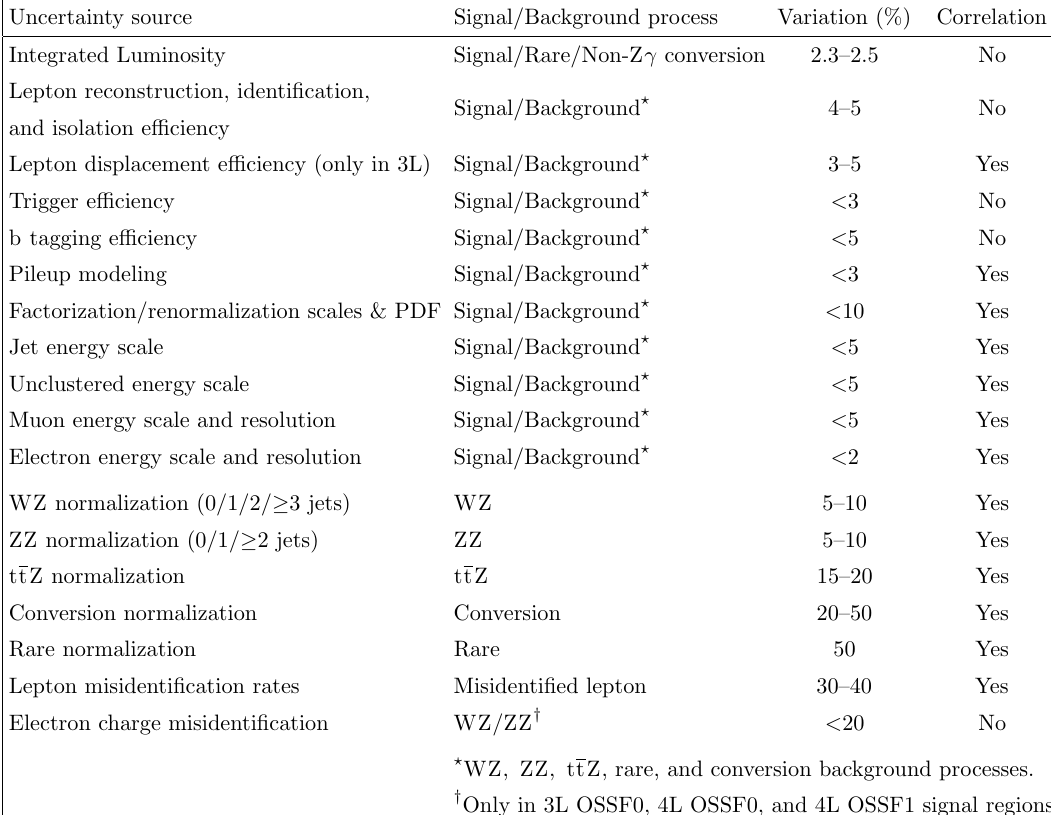
Table 3 . Sources of systematic uncertainties, a(cid:11)ected background and signal processes, relative variations of the a(cid:11)ected processes, and presence or otherwise of correlation between years in signal